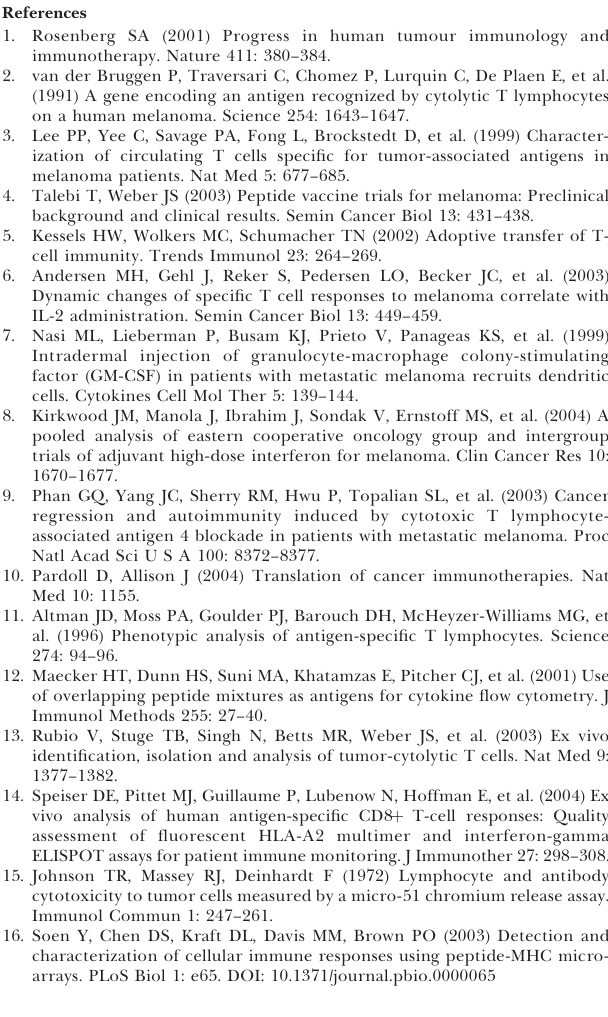
Figure S1. Expanded gp100 and MART-1 Specific T Cell Functional Activity The data used to generate Figure 5 are shown in this figure. (A) Number of cells responding per spot to gp100 or MART1 with secretion of IFN c or TNF a . (B) Average intensity value gp100 spots and MART1 spots for each individual secreted factor. Spot fluorescence intensity was measured from each spot and averaged over all replicates. Intensity values are then expressed as a percentage of an arbitrary value specific for each secreted